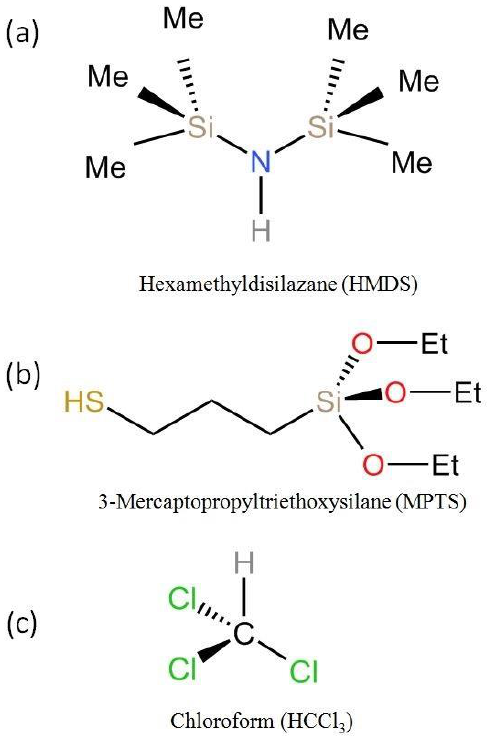
Figure 3. Structural formula of the chemicals required for the functionalization process; ( a ) 3-mer- captopropyltriethoxysilane (MPTS); ( b ) hexamethyldisilazane (HMDS) ( c ) chloroform (HCCl 3